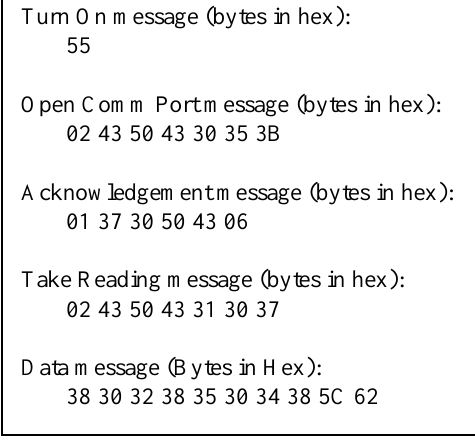
Figure 4. A&D UA-767PC BPM commands and